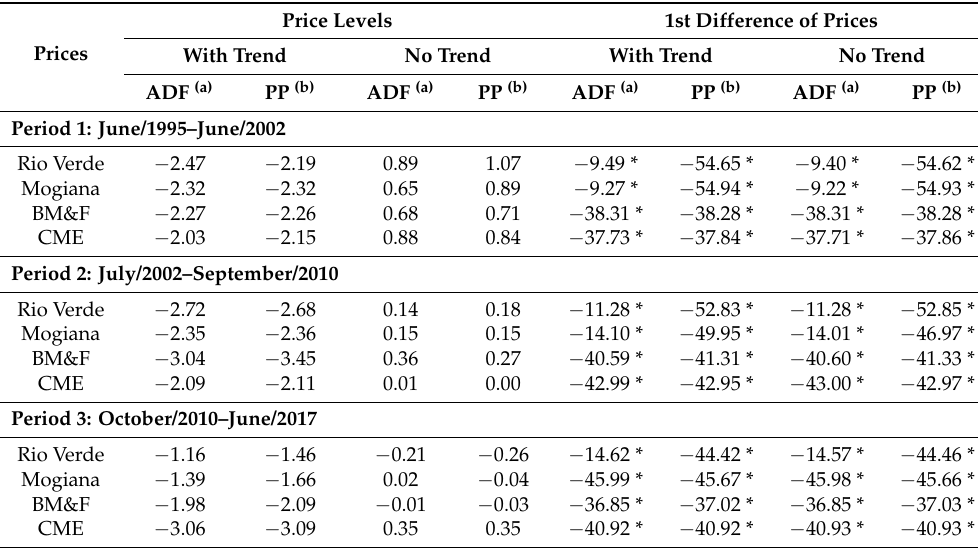
Table A1. Augmented Dickey–Fuller (ADF) and Phillips–Perron (PP) tests for daily corn log-prices